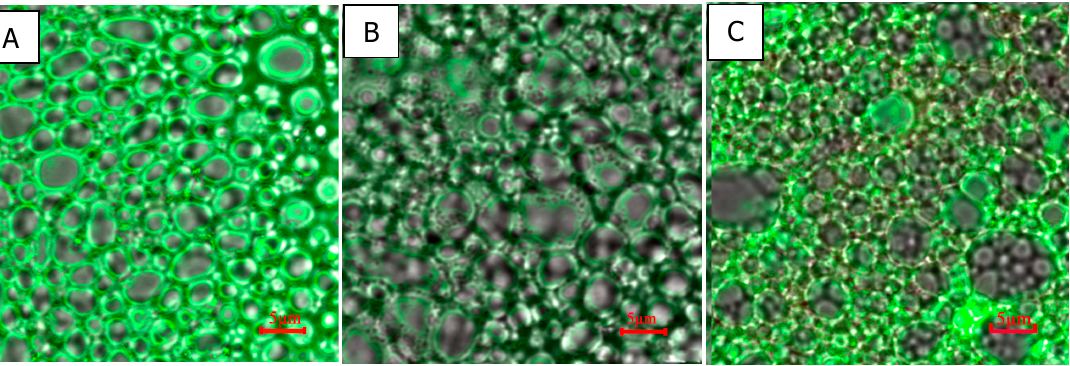
Figure 7. Laser confocal micrographics of ( A ), primary emulsion, ( B ), secondary emulsion, and ( C ) laccase-treated secondary emulsion.